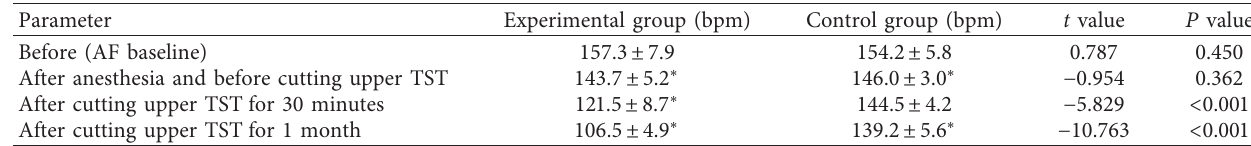
Figure 1: Cutting upper TST. (a) LSG (yellow arrow) was exposed on the top of the left thoracic cavity. (b) The lower part of LSG was resected (yellow arrow). Table 1: The effects of cutting upper TST on VR during